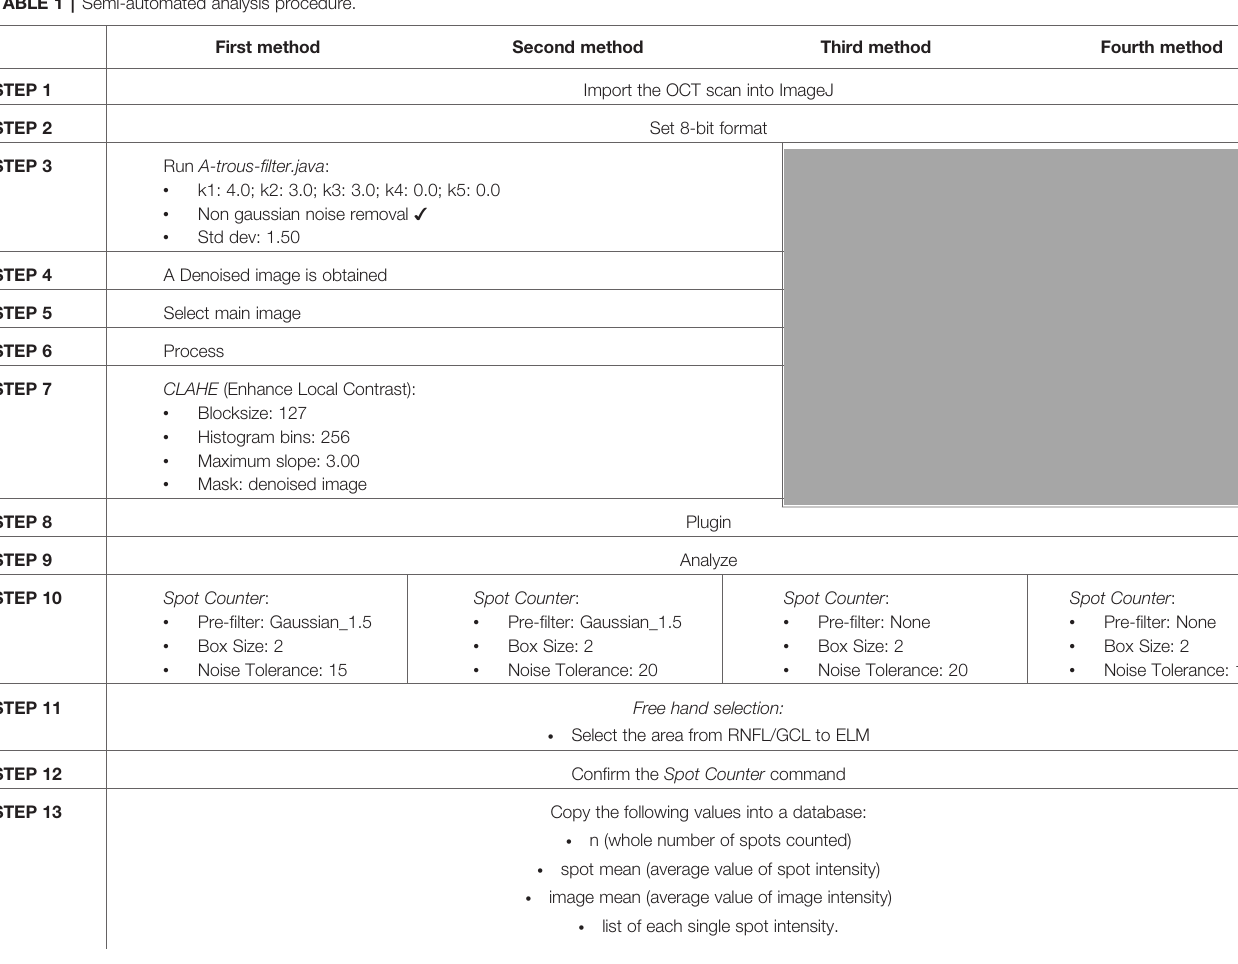
TABLE 1 | Semi-automated analysis